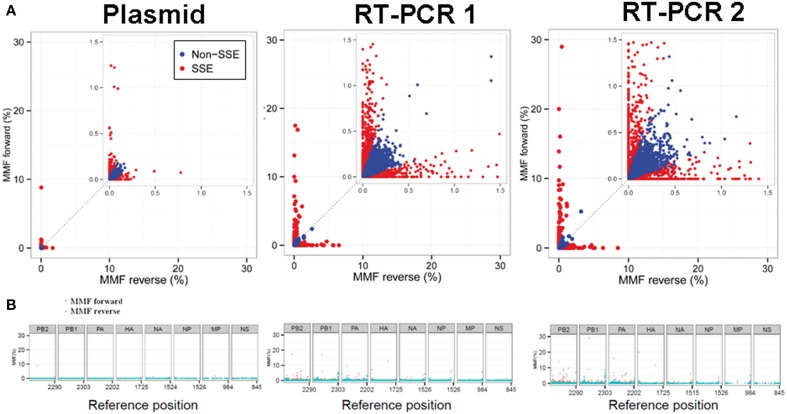
Sequence specific error (SSE) was defined as a position at which the difference in MMF of nucleotides mapping to the forward and the reverse strand exceeded the average MMF. Positions that were classified as SSE are highlighted in red. Both RT-PCR samples showed increased MMF's compared to the plasmid sample indicating introduction of mismatches due to the RT-PCR amplification process (A). The distribution of SSE's over the influenza genome was primarily located in the large polymerase segments of the RT-PCR samples and at segment ends (B).